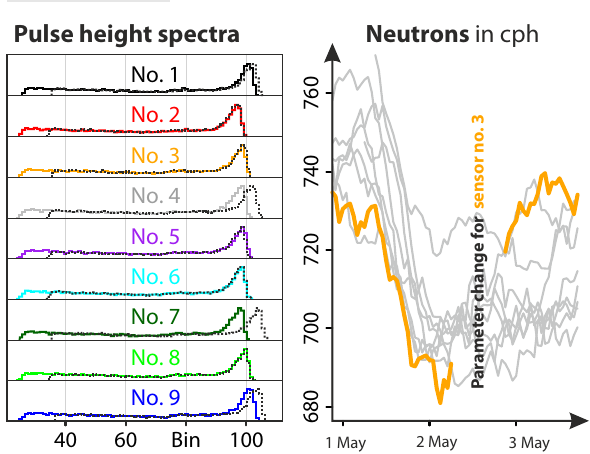
Figure 6. Adjustment of the detector parameters harmonized the pulse height spectra of the nine sensors (before: dotted black) and increased their range towards the lower left end. The impact on the count rate is shown exemplarily for sensor 3